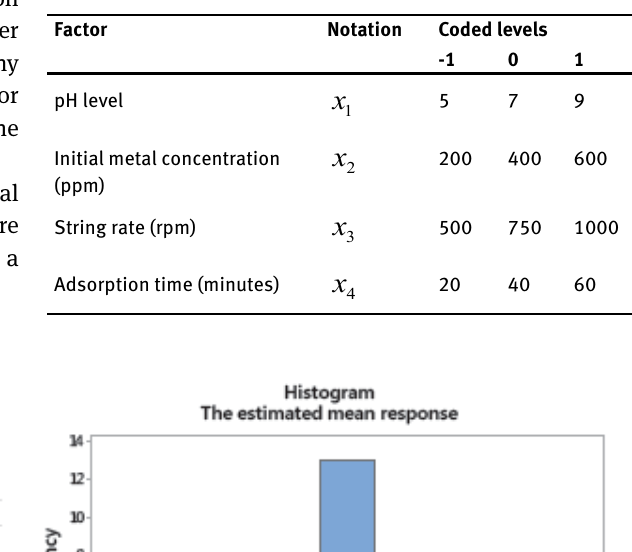
Table 1: Coded factors and their levels.